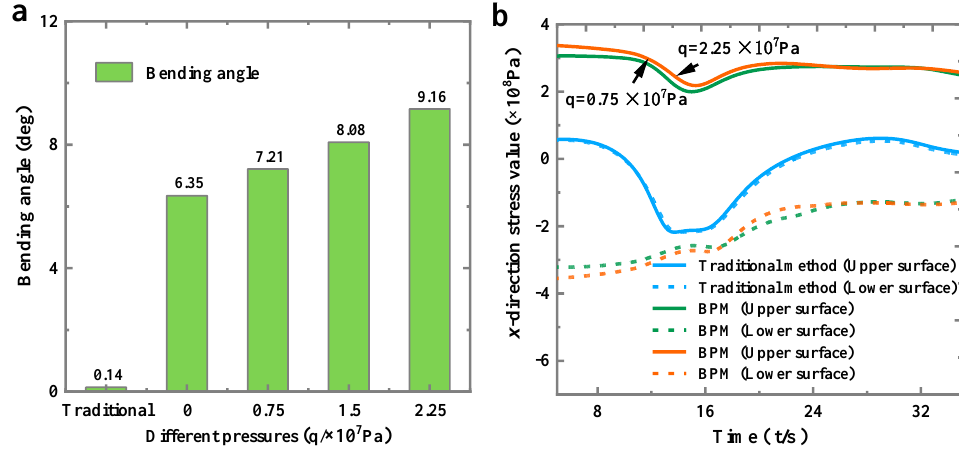
Figure 10. Comparison of stress between the two methods under different pressures: ( a ) bending angle and ( b ) stress